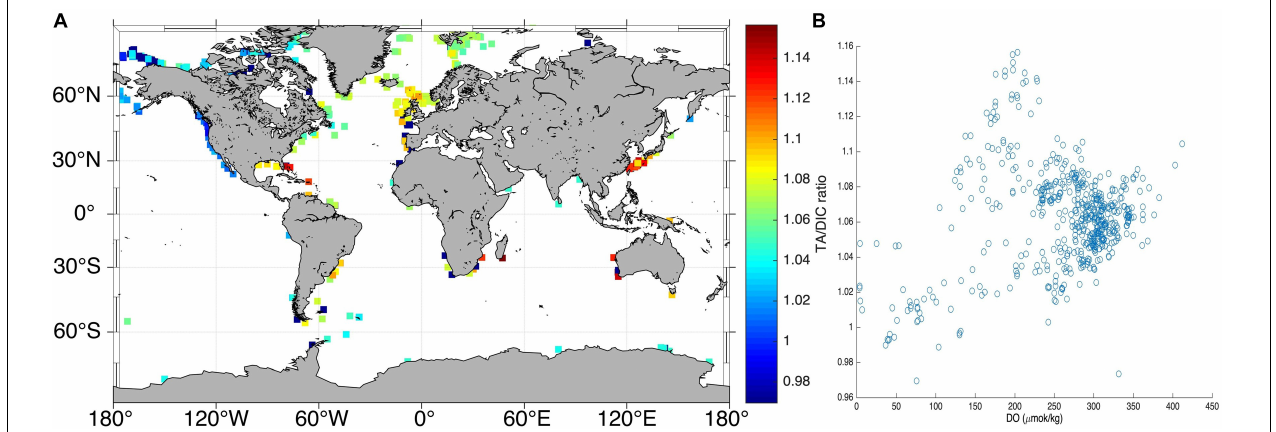
FIGURE 5 | Global trend of TA/DIC ratio above the seafloor for oxygen-limited coastal setting. (A) Global distribution of TA/DIC at 100–250 m bathymetry within 20 m above the seabed. (B) Global distribution of TA/DIC at different oxygen concentrations. It can be noticed that the minimum TA/DIC ratio is about 1, under oxygen-limited condition in the shallow bathymetry settings. Data Resource: GLODAPv2 (Key et al., 2015; Lauvset et al., 2016; Olsen et al.,